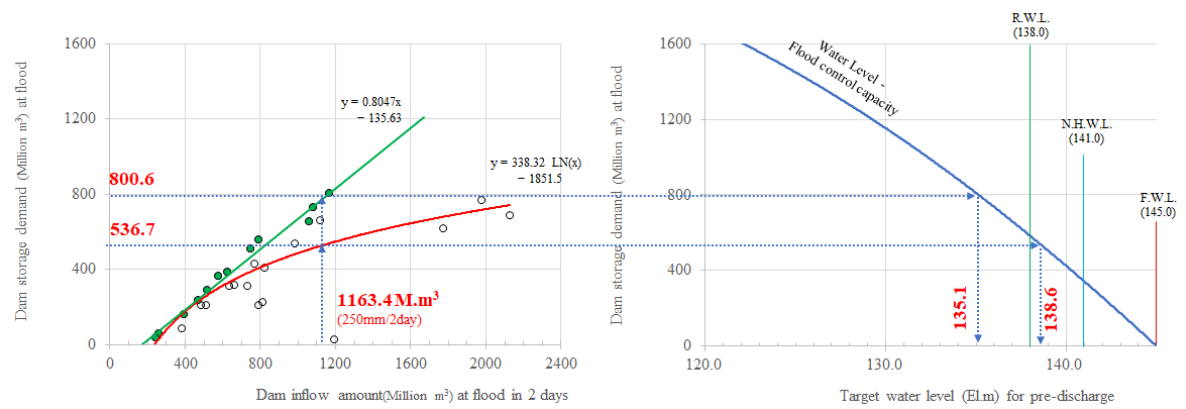
Figure 8. Diagram to estimate flood control capacity demand and target water level for predischarge of the Chungju dam; red lined indicats average RSF curve, and green line denotes high threshold line of RSF curve, blue dot line indicates the process to estimate flood control capacity and target water level.